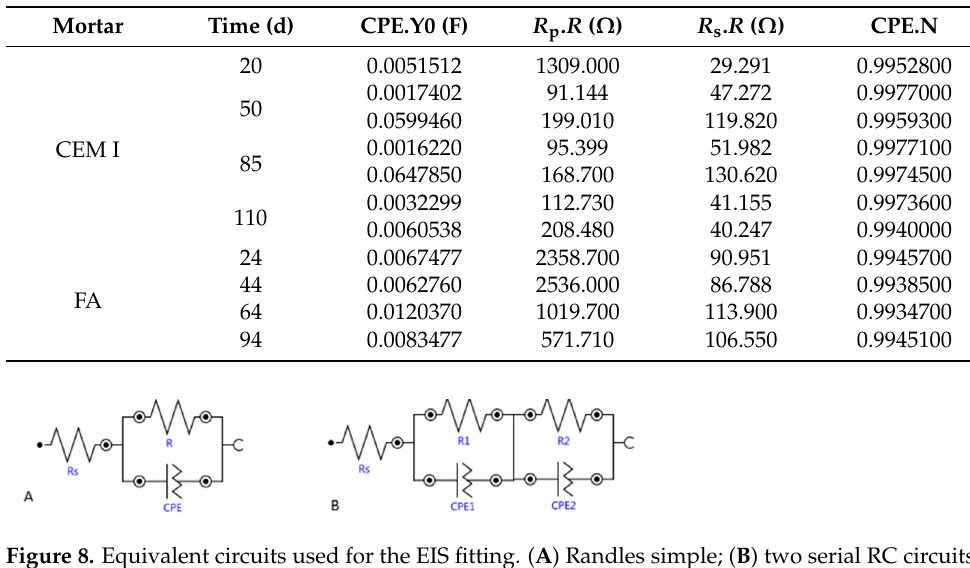
Table 7. Characteristic parameters obtained from the fitting of the Nyquist semicircle obtained by the EIS during the ECE treatment.